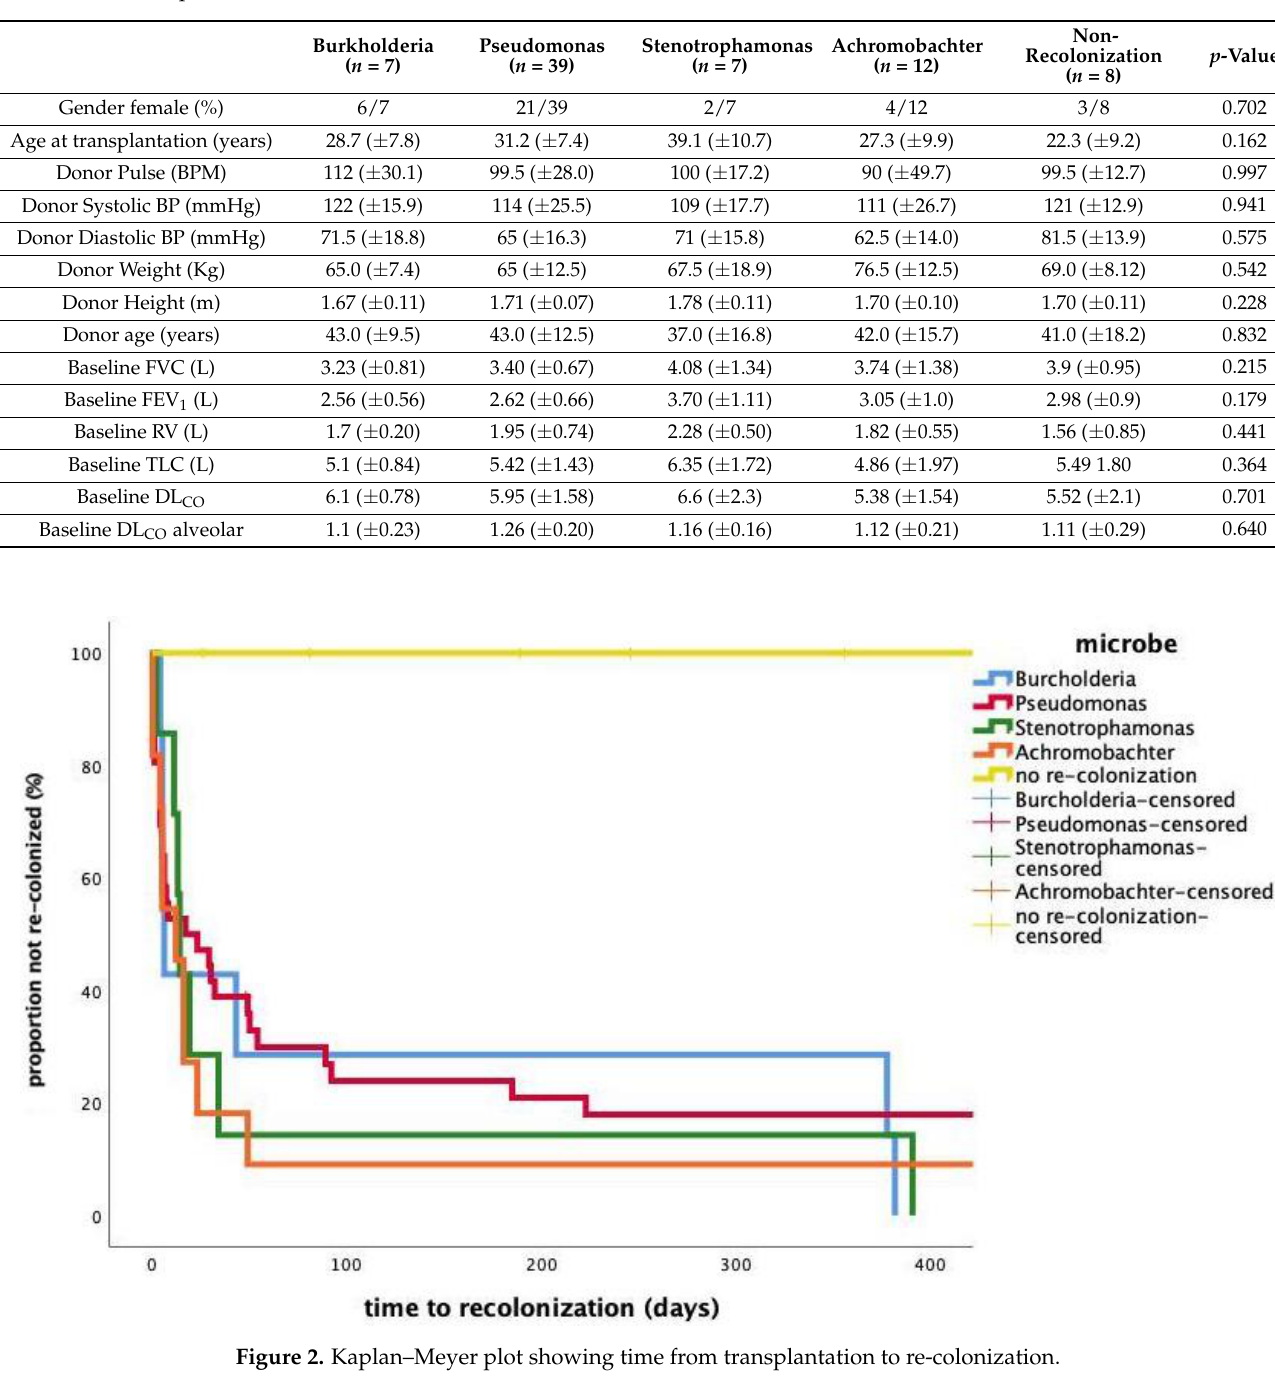
Table 1. Demography of the patients including lung function at baseline and at chronic lung allograft dysfunction (CLAD). Variables are presented as median and standard deviation.